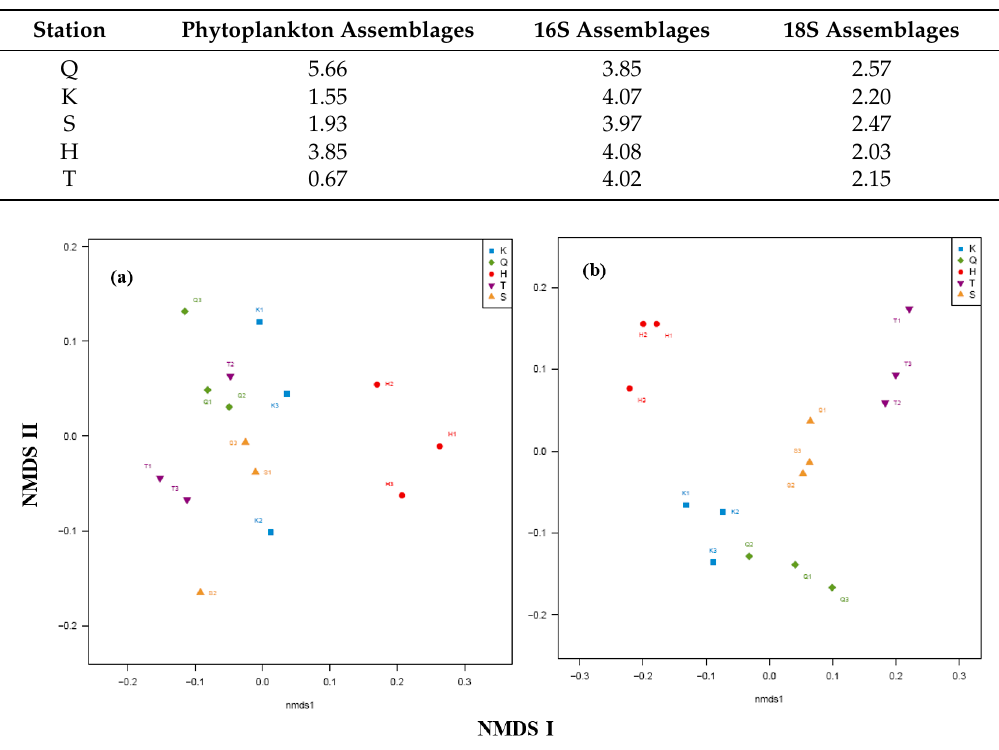
Table A1. Shannon-Wiener index ( H ’) of phytoplankton, 16S and 18S assemblages. H’ values were